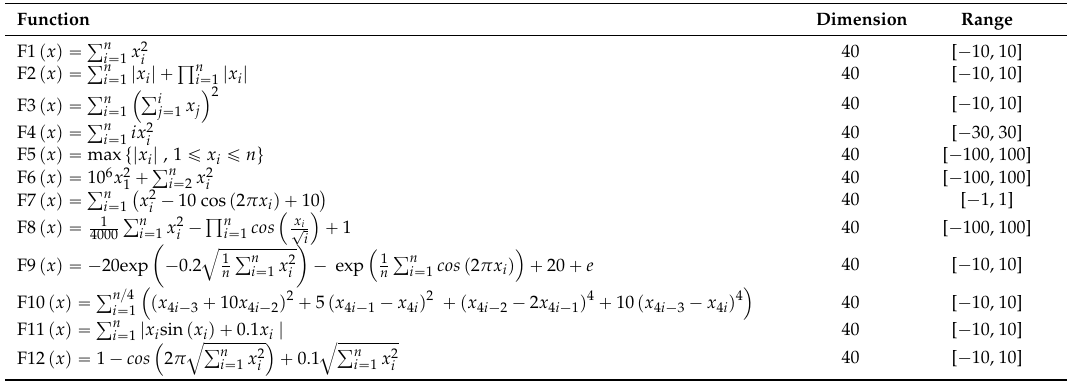
Table 1. Twelve benchmark